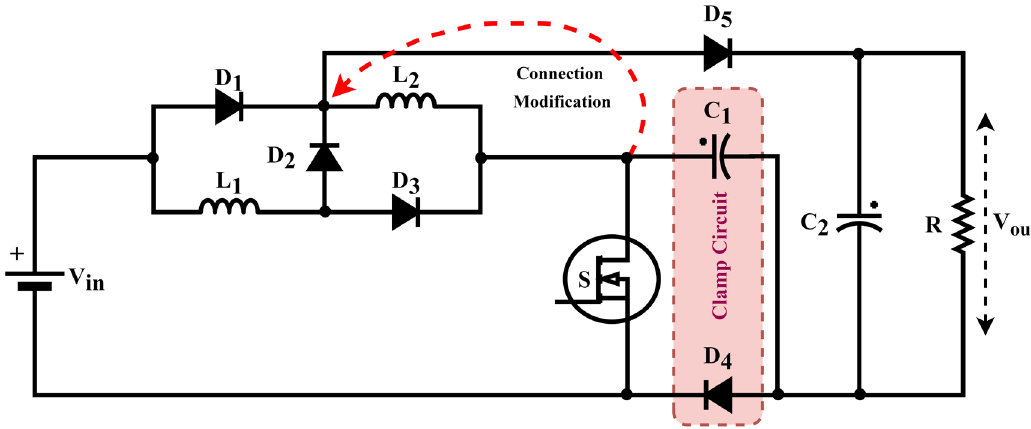
Figure 2. Suggested SI-based MQZS step-up converter structure.